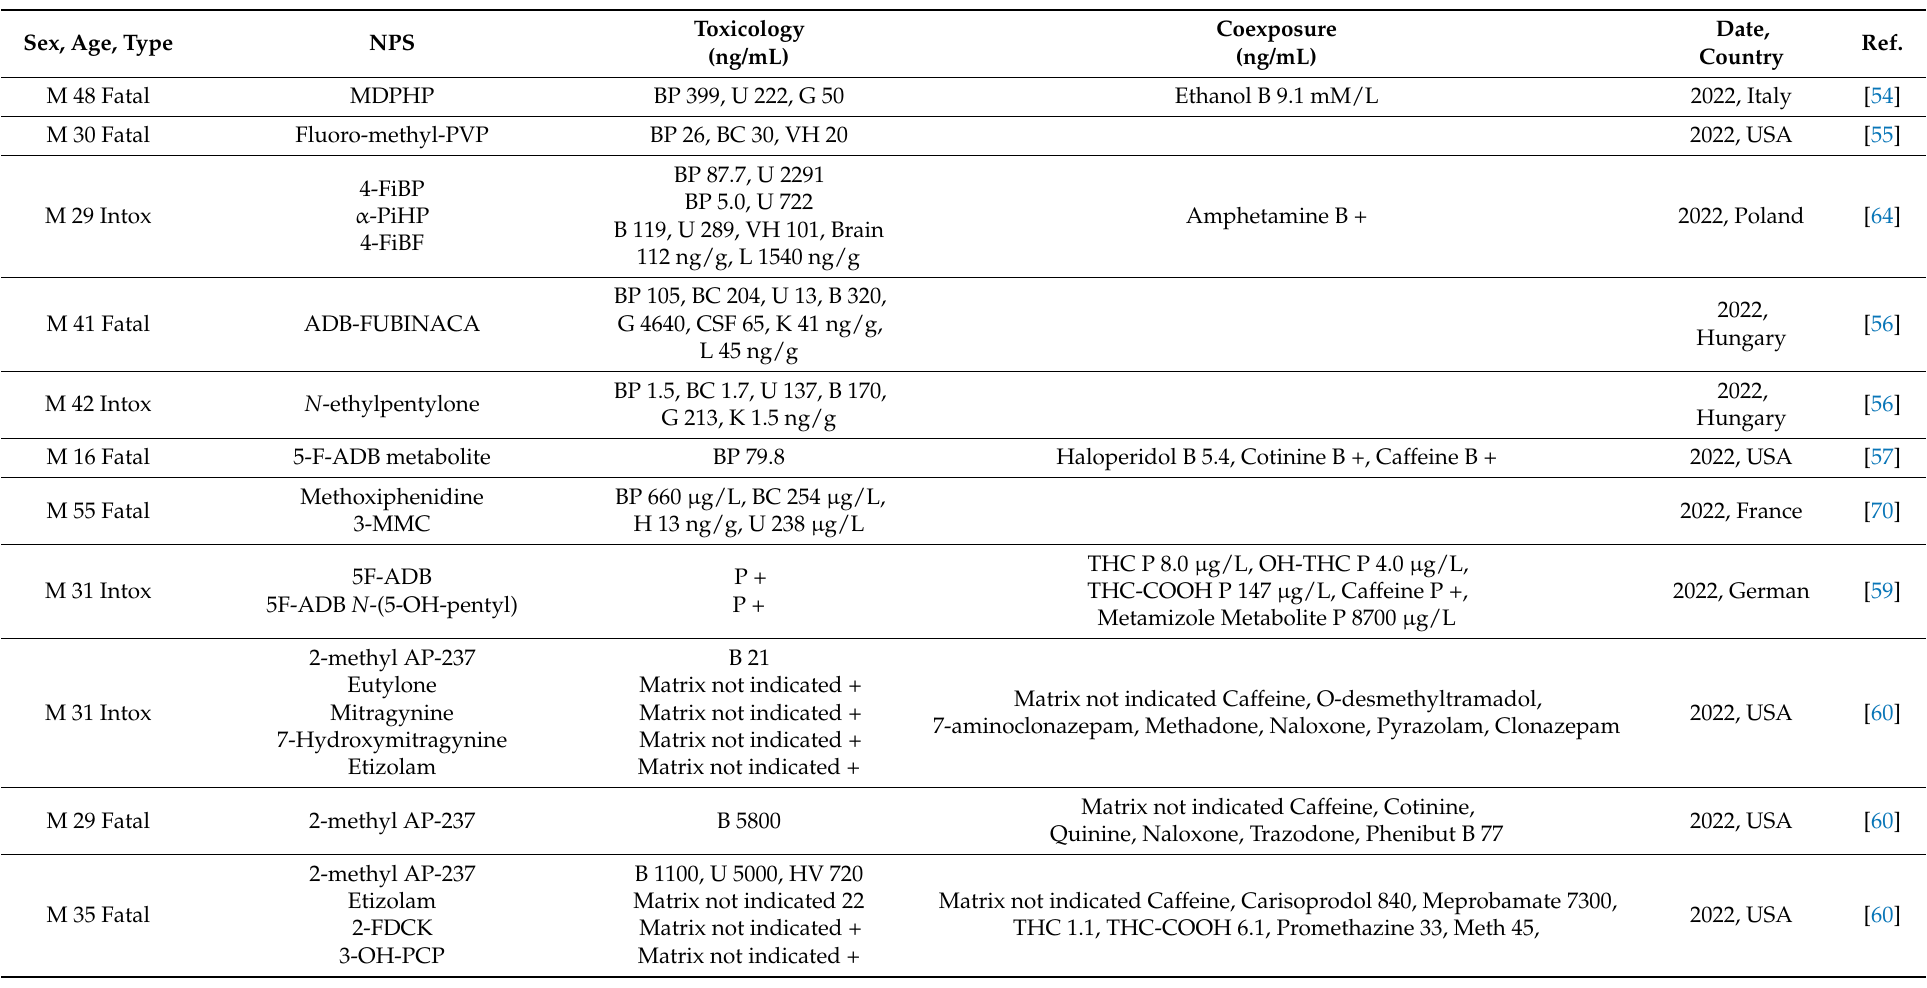
Table 1. NPS-related fatalities and intoxications reported in the literature during COVID-19 (January 2020–March